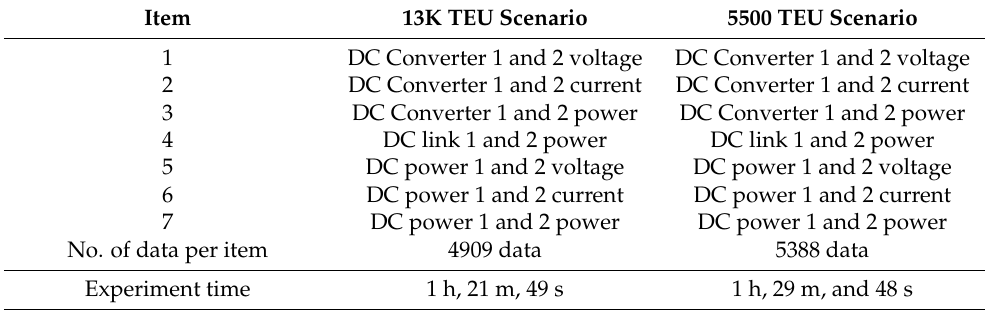
Table 5. Data acquisition